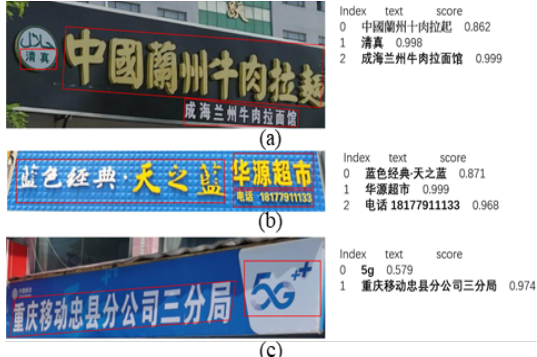
Figure 9 . Examples of POI-related text recognition using the pre- training model (text in Chinese). (a) restaurant; (b) convenience shop; (c) mobile